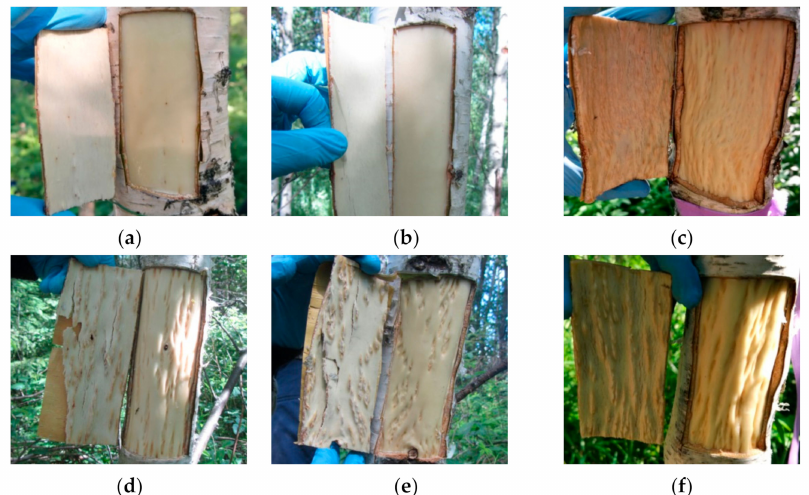
Figure 2. Debarked wood surface and inner bark surface of B . pendula var. pendula ( a ), non-figured ( b ), and figured ( c – f ) B . pendula var. carelica